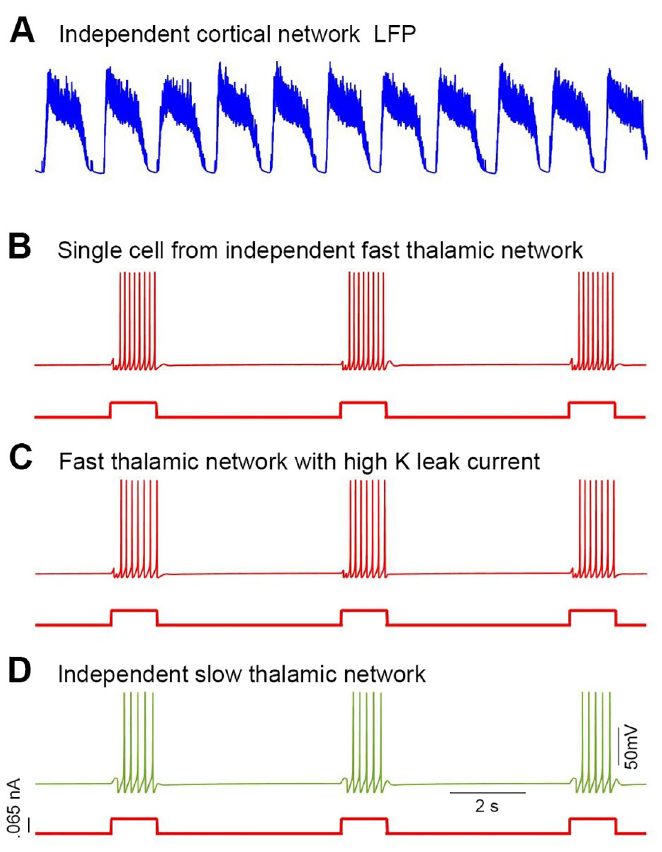
Fig 8. Each individual network response. A , The resultant local field potential of the individual (two layered) cortical network. B , Single TC cell exhibits frequency ~16 Hz in individual fast thalamic subnetwork when step current was applied. C , The TC cell of fast thalamic subnetwork with high potassium leak current shows relatively weaker response (~14 Hz). D , The TC cell of slow thalamic subnetwork shows slow frequency ~10Hz.